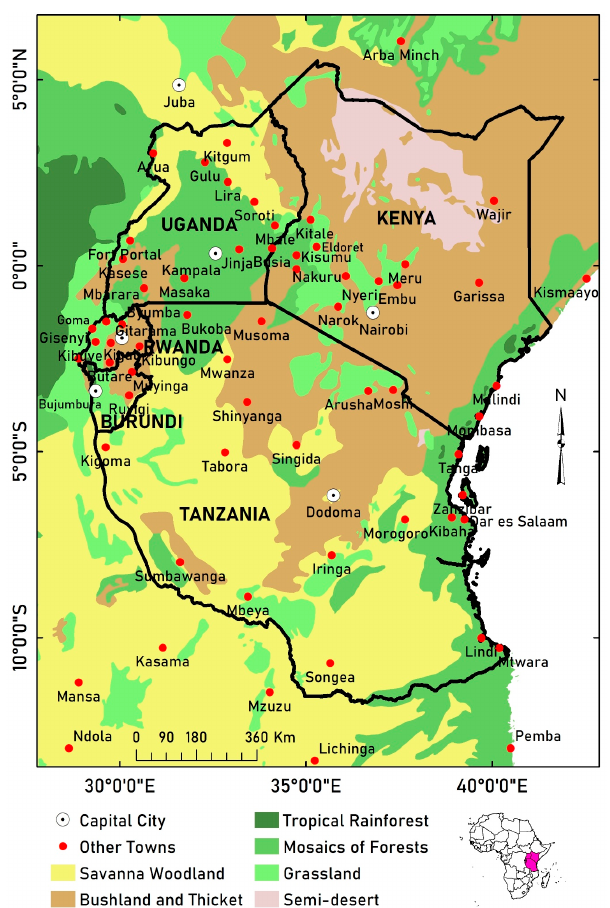
Figure 1. Map of East Africa showing its vegetation cover along with the capital cities and other towns.